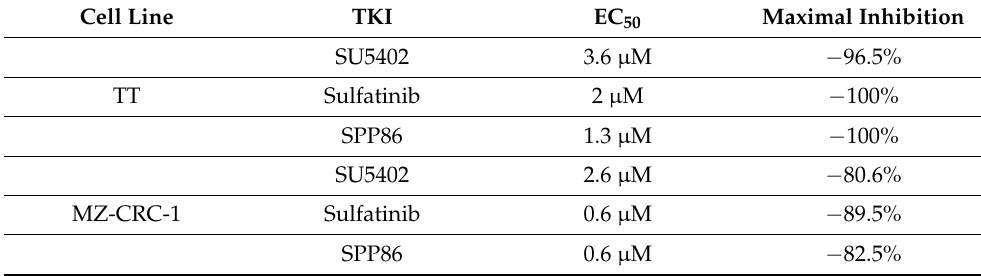
Table 2. Growth inhibition of MTC cell lines after 6 days of incubation with TKIs. Cell